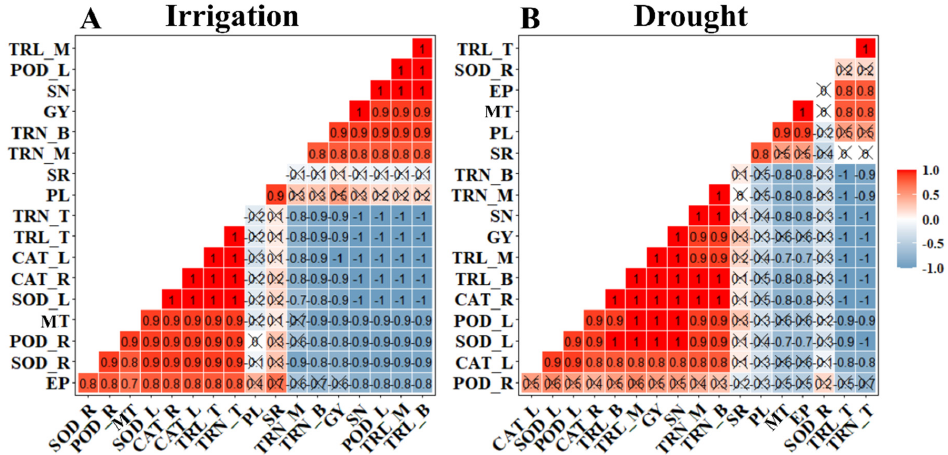
Figure 7. The Pearson’s correlation matrix among traits and oxidative enzymes, under irrigation ( A ), and under drought ( B ). The scale bar on the right shows the negative and positive intensity of correlation (1 to − 1). GY , Grain yield; MT , Number of maximum tillers; PL , Panicle length; EP , Number of effective panicles; SN , Spikelet number per panicle; SRR , Seed-setting rate; TRN_T , Total number of roots at the top (0–10 cm); TRN_M , Total number of roots at the middle (10–30 cm); TRN_B , Total number of roost at the bottom (30–50 cm); TRL_T , Total number of roots at top (0–10 cm); TRL_M , Total number of roots at the middle (10–30 cm); TRL_B , Total number of roots at the bottom (30–50 cm); SOD_L , Superoxide dismutase in the leaves; SOD_R, Superoxide dismutase in the roots; CAT_L, Catalase in the leaves; CAT_R, Catalase in the roots; POD_L, Peroxidase in the leaves; and POD_R, Peroxidase in the roots.